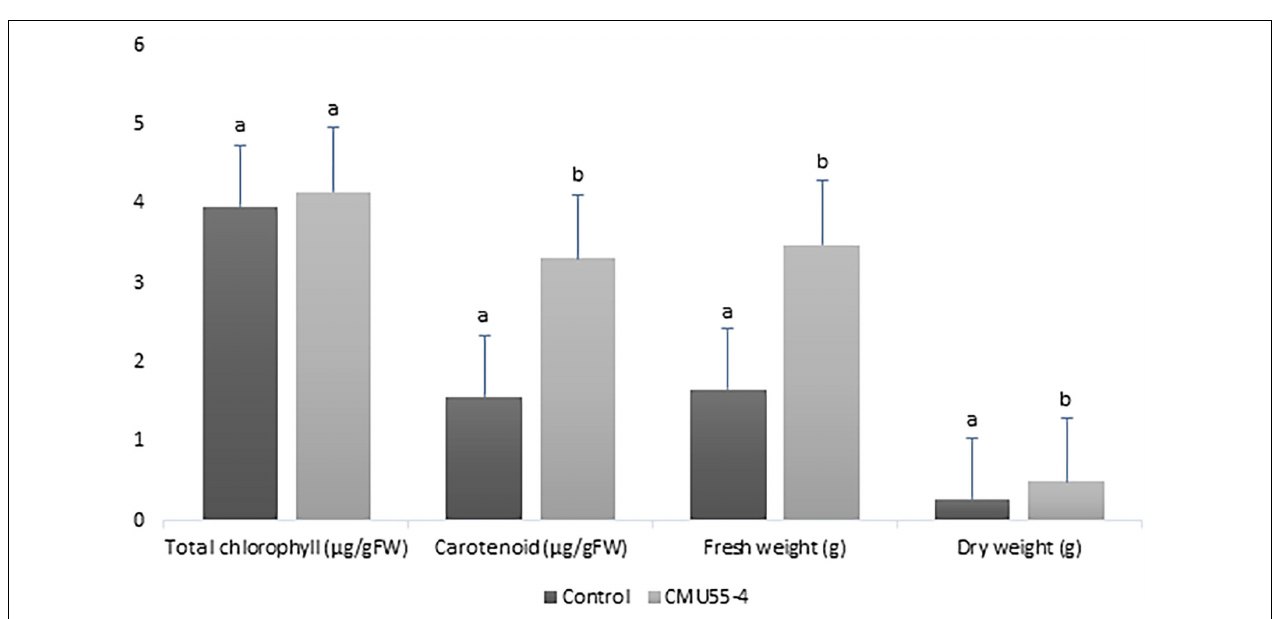
FIGURE 3 | Effects of Micromonospora strain CMU55-4 toward the growth of P. sphaericum. a, b indicated significant difference in statistical analysis tested by SPSS independent T -test ( p < 0.05), n =